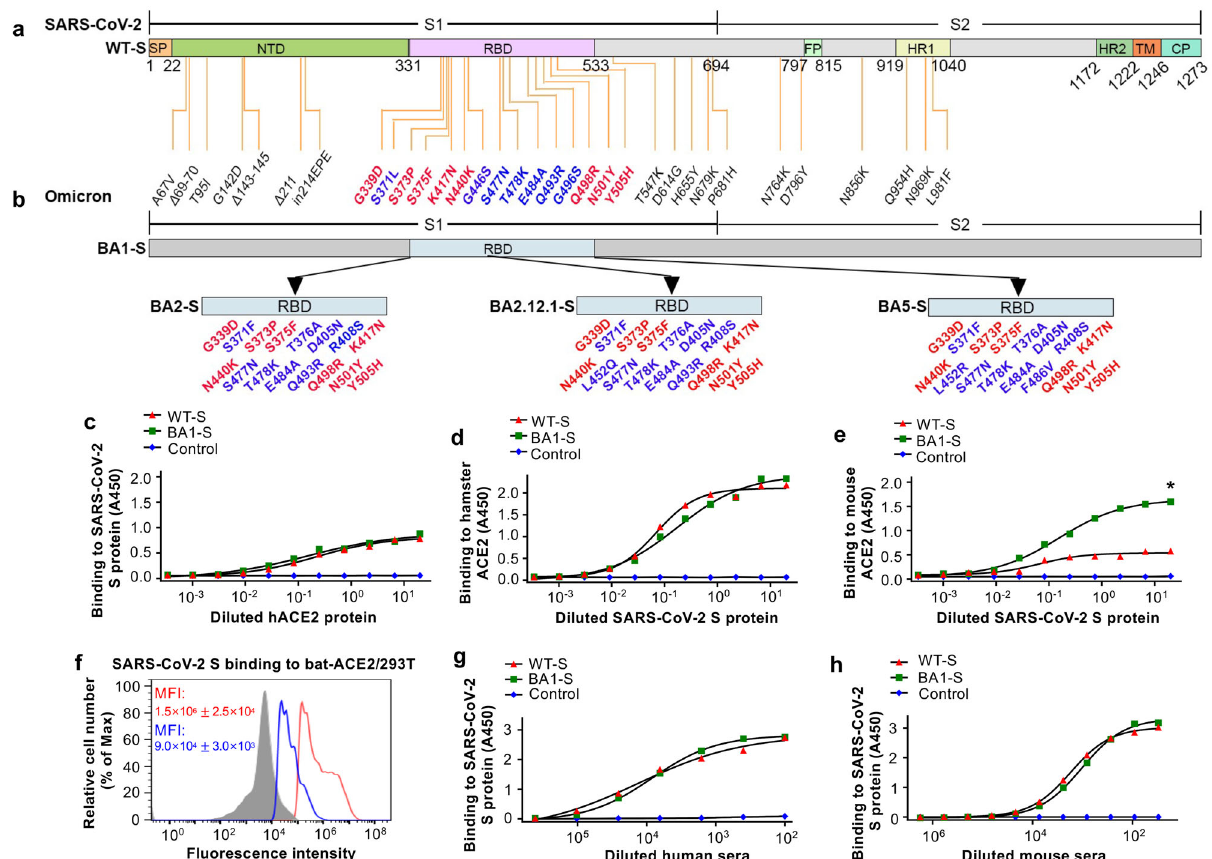
Fig. 1 Schematic map of spike (S) protein of SARS-CoV-2 original strain and Omicron subvariants and characterization of SARS-CoV-2 BA1-S protein. Schematic map of SARS-CoV-2 S protein of the original wild-type (WT-S) strain ( a ) and Omicron BA1 subvariant (BA1-S) ( b ). Mutant amino acid residues of Omicron BA1 subvariant are shown in the S1 (including N-terminal domain (NTD) and receptor-binding domain (RBD)) and S2 subunits of S protein, respectively. Mutant amino acid residues in the RBD of Omicron BA2, BA2.12.1, and BA5 are shown ( b ). SP signal peptide. FP fusion peptide. HR1 and HR2, heptad repeat regions 1 and 2. TM transmembrane domain. CP cytoplasmic tail. ELISA analysis of binding of Omicron BA1-S protein (BA1-S) or original S protein (WT-S) to human angiotensin-converting enzyme 2 (hACE2) ( c ), hamster ACE2 ( d ), and mouse ACE2 ( e ) proteins, respectively. Control, PBS. Statistical signi fi cance between the binding of WT-S and BA1-S proteins to mouse ACE2 protein was analyzed using a two-tailed student t -test, and * ( P < 0.05) indicates a signi fi cant difference. f Flow cytometry analysis of binding of BA1-S (blue line) and WT-S (red line) proteins to bat ACE2-expressing 293T cells (bat-ACE2/293T). 293T cells were transiently transfected with bat ACE2 plasmid and incubated with each protein (5 µg/ml) for analysis by fl ow cytometry. Gray shading, mock-incubated cells. MFI, median fl uorescence intensity. ELISA for detection of binding of WT-S and BA1-S proteins to SARS-CoV-2 S-vaccinated human ( g ) and mouse ( h ) serum-neutralizing antibodies, respectively. The data (in c – h ) are expressed as mean ± standard deviation of the mean (s.e.m.) of the duplicate to quadruple wells. The experiments were repeated twice, leading to similar